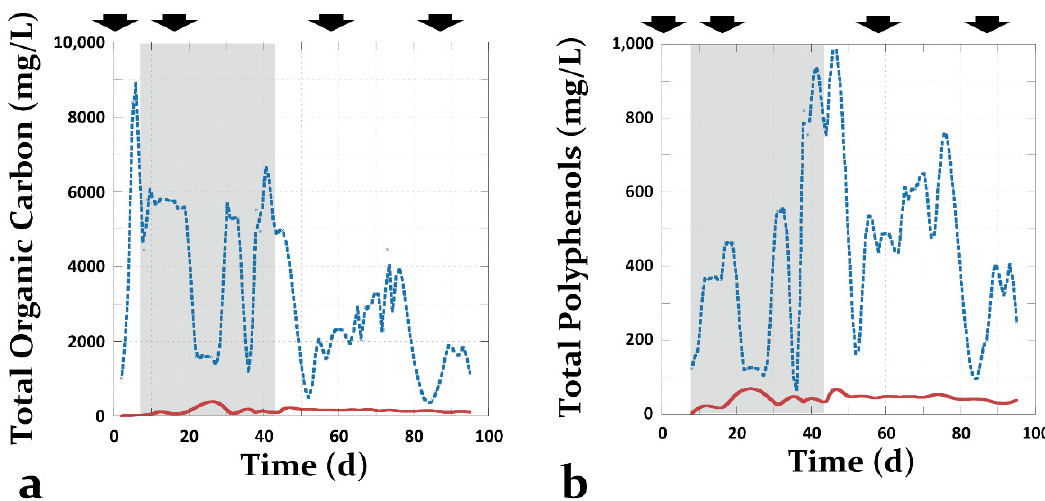
Figure 3. Temporal variation of feed and permeate characteristics. Plots of ( a ) TOC concentration; and ( b ) TPh concentration of the feed (discontinuous line), and the permeate (continuous line) during MBR acclimatization period; the arrows indicate sample collection time points for metagenomic analysis; the shaded area indicates the time period when both CSW and TOPW were fed to the MBR, CSW and TOPW were solely fed before and after this period, respectively.